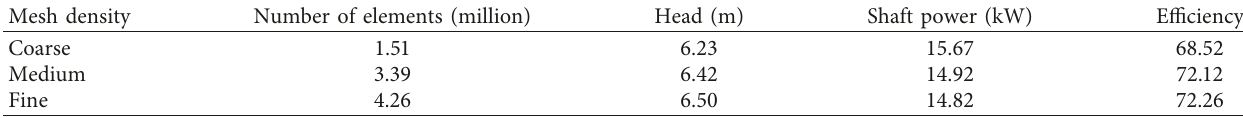
Table 3: Mesh size for the calculation model (million).